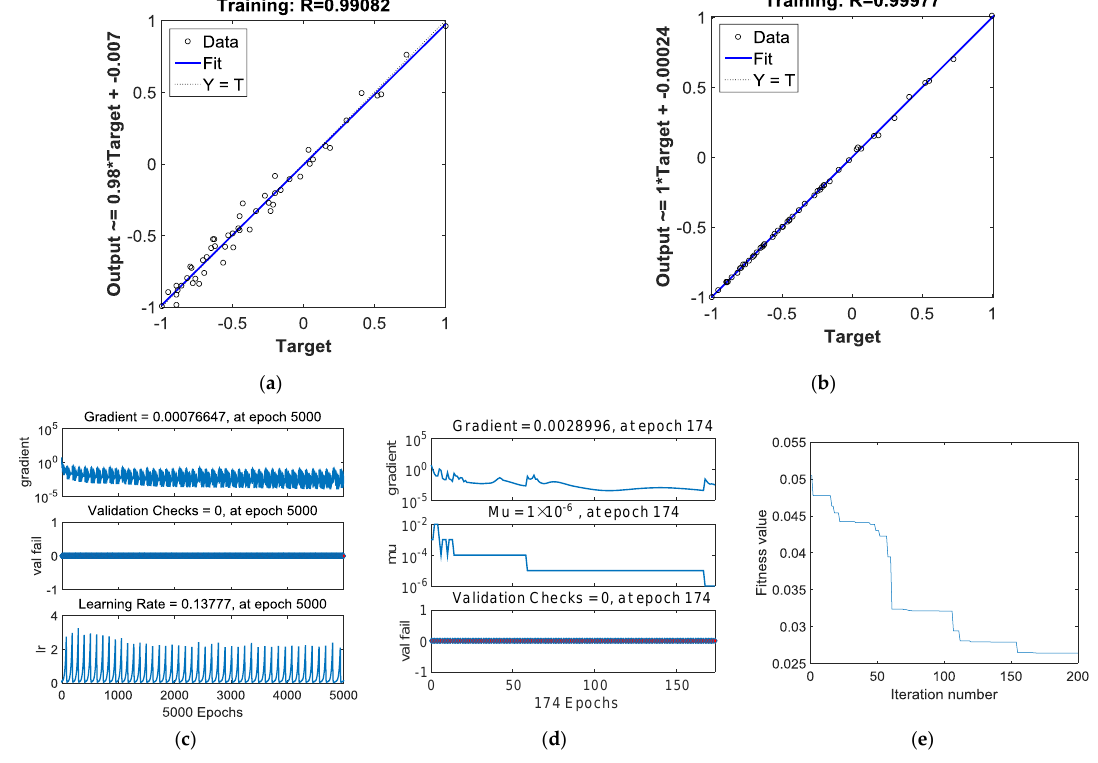
Figure 9. ( a ) Plotting linear regression of BPNN; ( b ) plotting linear regression of PSO-BPNN; ( c ) training state of BPNN; ( d ) training state of PSO-BPNN; ( e ) the Fitness value graph of PSO iteration.